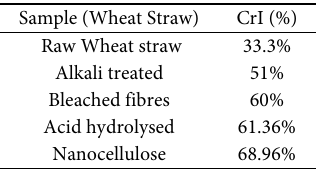
Table 4. Crystallinity Index (CrI